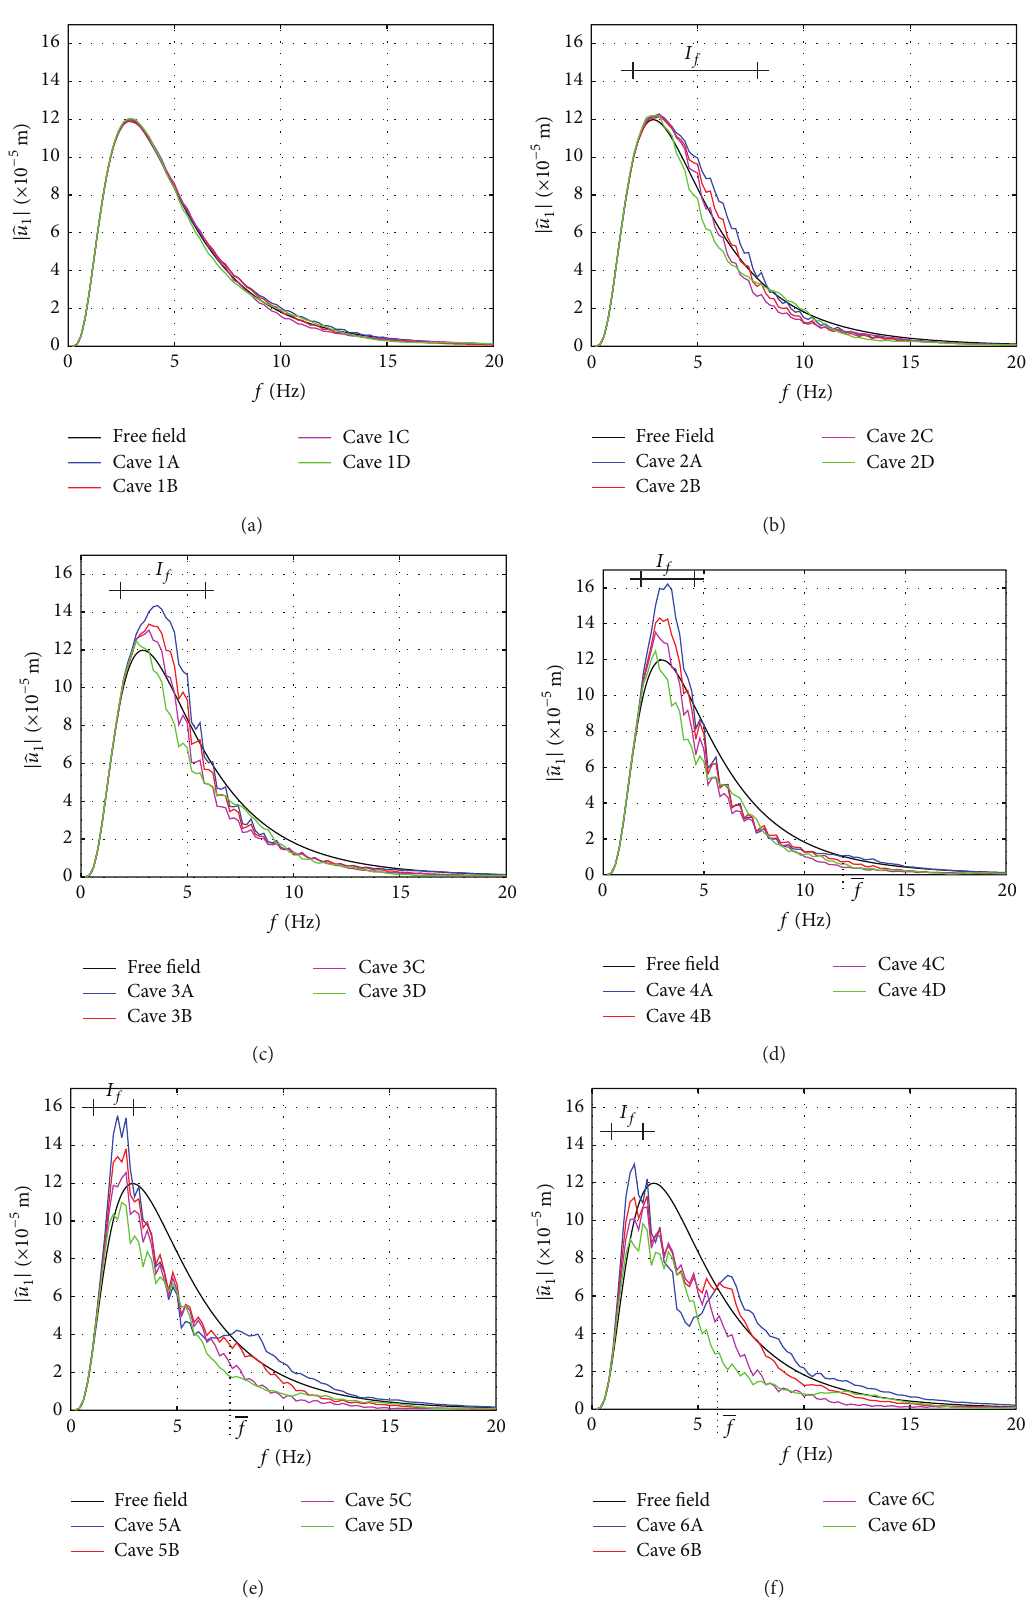
Figure 14: Frequency spectra |̂𝑢 1 (𝑂,2𝜋𝑓)| for different cave sizes and